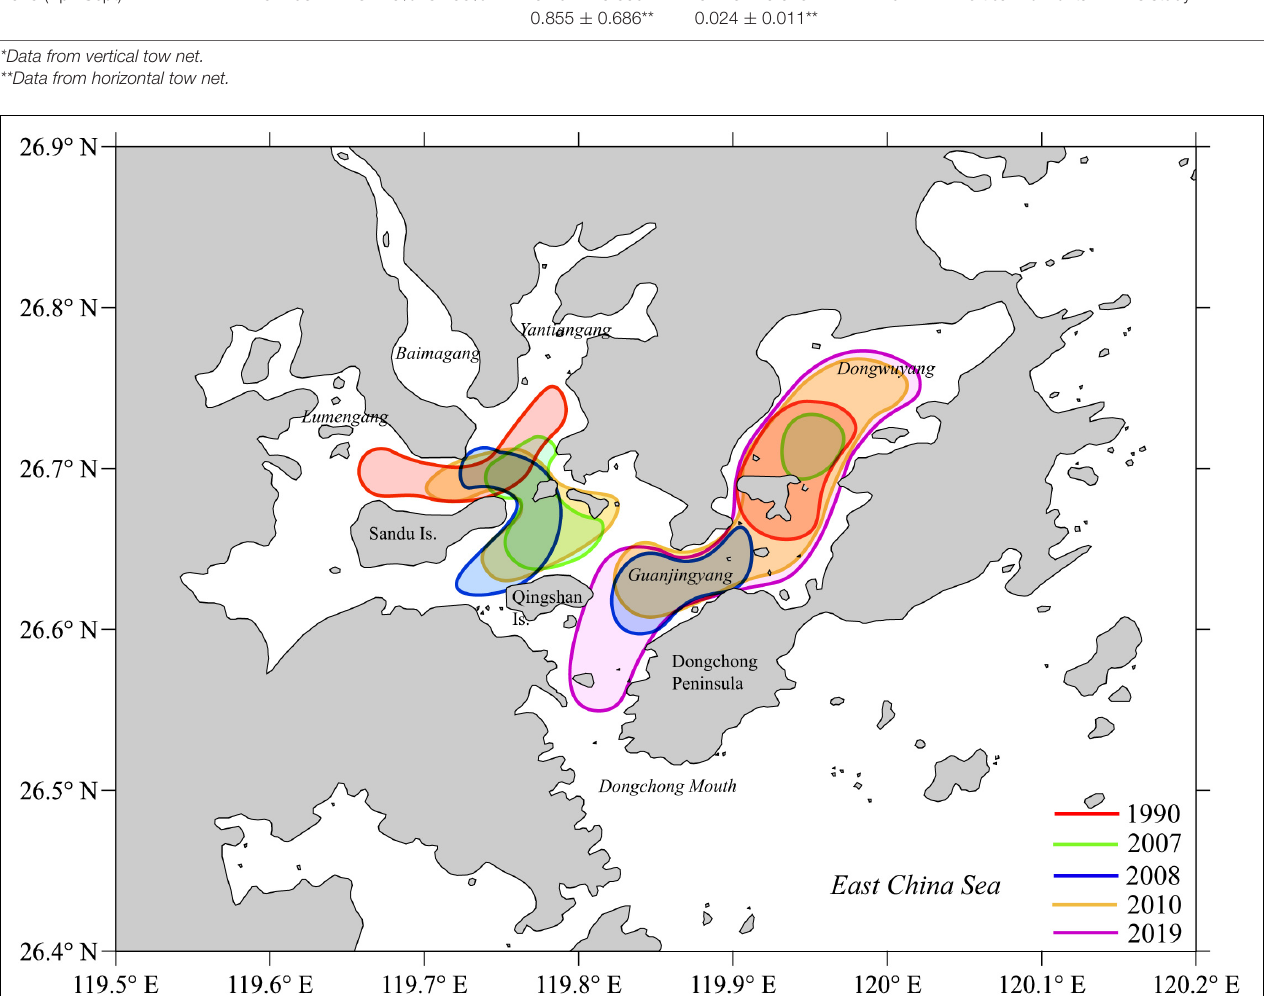
Vertical Horizontal This